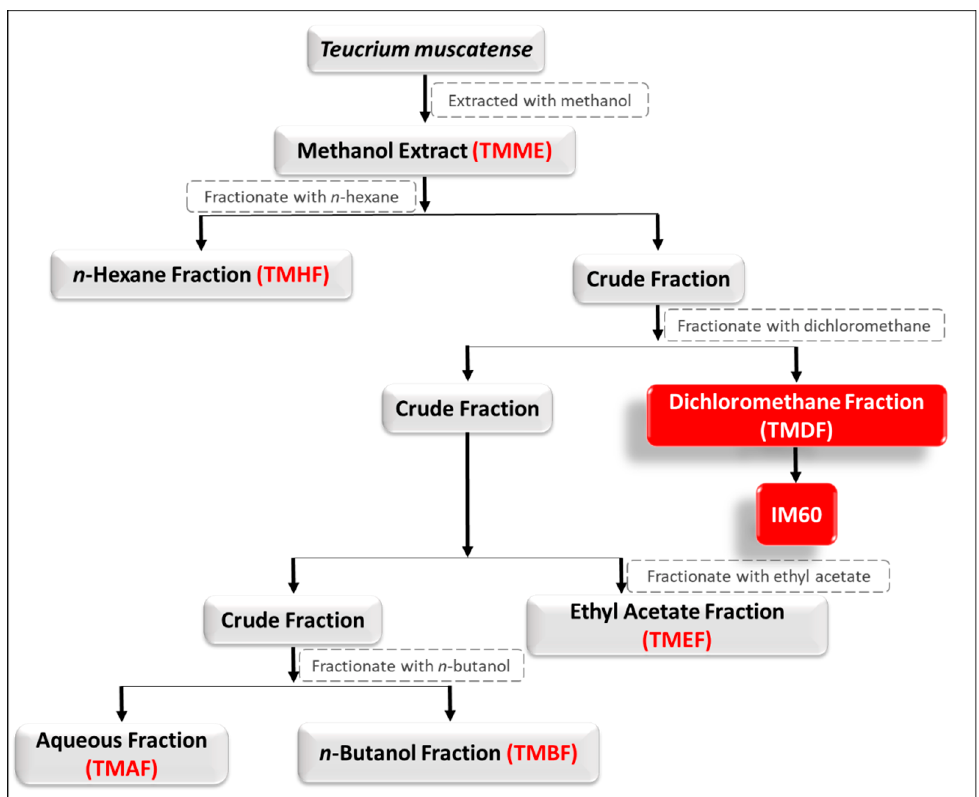
Figure 10. Schematic illustration of the extraction strategy used and isolation of the various fractions and IM60 from the methanolic extract. TMDF and IM60 are highlighted in red as they were the ones characterized in this study in more depth.